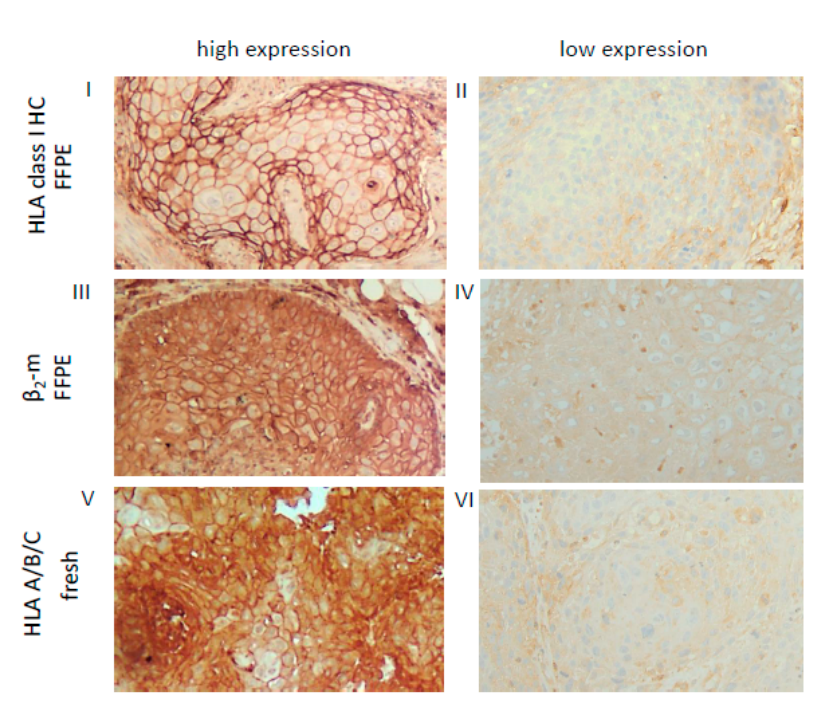
Table 3. Classification of OSCC Lesions According to the HLA-I/APM Expression.